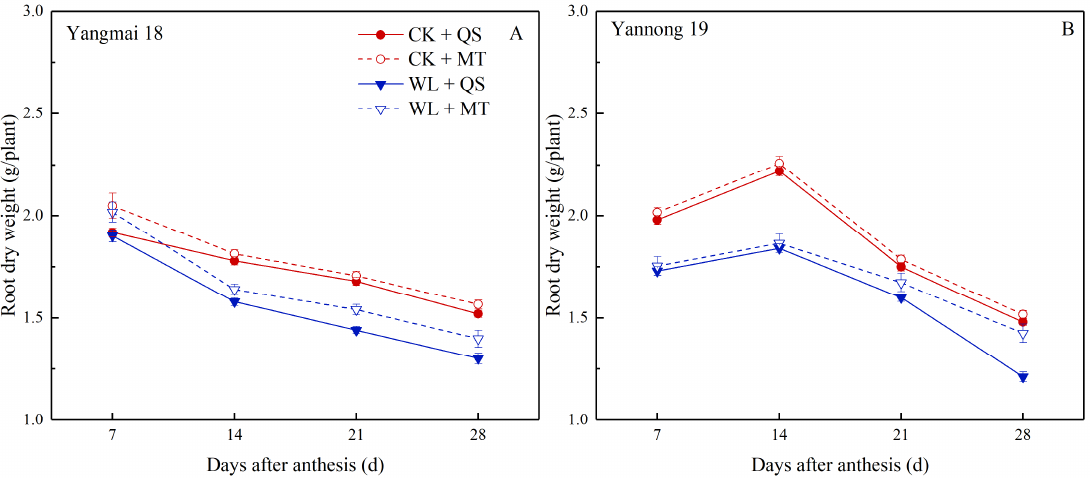
Figure 3. Post-flowering changes in root dry weight of Yangmai 18 ( A ) and Yannong 19 ( B ) under different treatments, i.e., CK + QS: leaf spraying with distilled water under non-waterlogged conditions; CK + MT: leaf spraying with 100 μmol·L −1 of melatonin under non-waterlogged conditions; WL + QS: leaf spraying with distilled water under waterlogged conditions; WL + MT: leaf spraying with 100 μmol·L −1 of melatonin under waterlogged conditions.